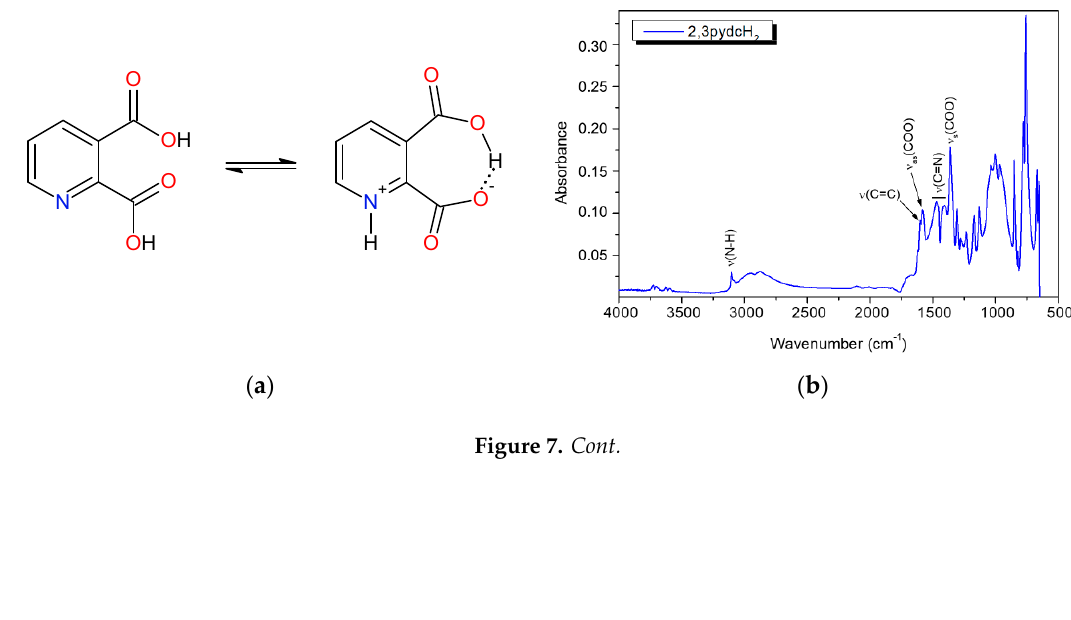
( d ) Figure 7. ( a ) The non-zwitterionic and zwitterionic form of 2,3pydcH 2 ; the FT-IR spectra of: ( b ) 2,3pydcH 2 , ( c ) complex 1 and ( d ) complex 2 . 2.4. Thermal Analysis To determine the thermal stability of the Bi(III) complexes, thermogravimetric analysis was carried out. Coordination polymer 1 was stable at temperatures up to 35 °C, and the first decomposition step was attributed to the loss of water molecules (1.59%, calcd: 1.64%) (Figure 8a). Next, at temperatures up to 450 °C, we observed the gradual decomposition of the coordinating mono-deprotonated and deprotonated pyridine-2,3-dicarboxylate anions (55.68%, calcd: 55.92%). At the end of this process, Bi 2 O 3 remained as a final residue (42.73%, calcd: 42.44%). Polymer 2 was stable up to approximately 140 °C and then decomposed in two main stages (Figure 8b). The first stage involved the thermal dissociation of the two lattice triethylammonium cations (25.49%, calcd: